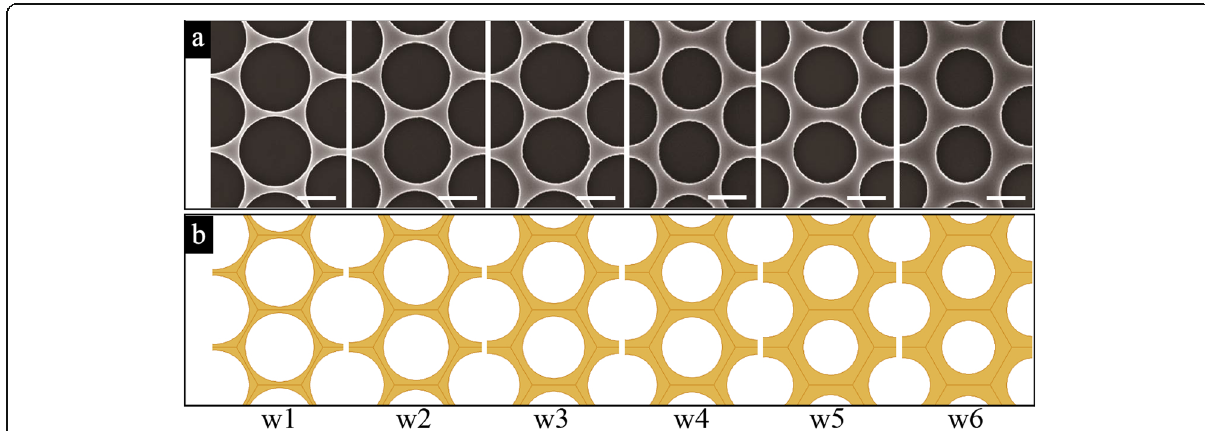
Fig. 2 The structure images of AuNM. a Top-view SEM images of six different experimental samples, and b top-view drawings of six different numerical models. Scale bar: 500 nm